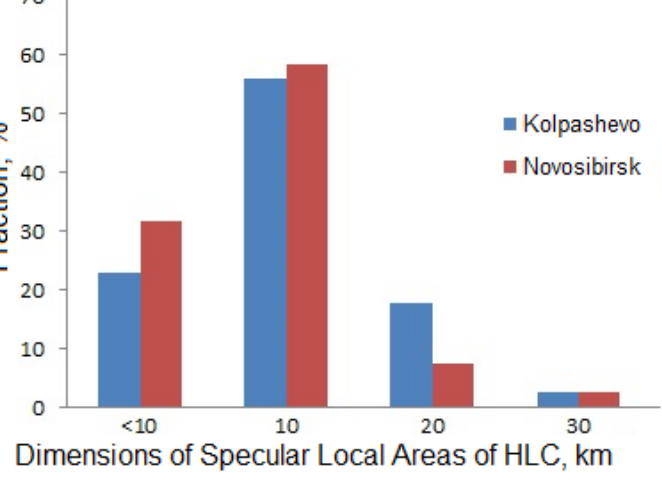
Figure 6. Distribution of HLC specular area sizes (2016–2020).